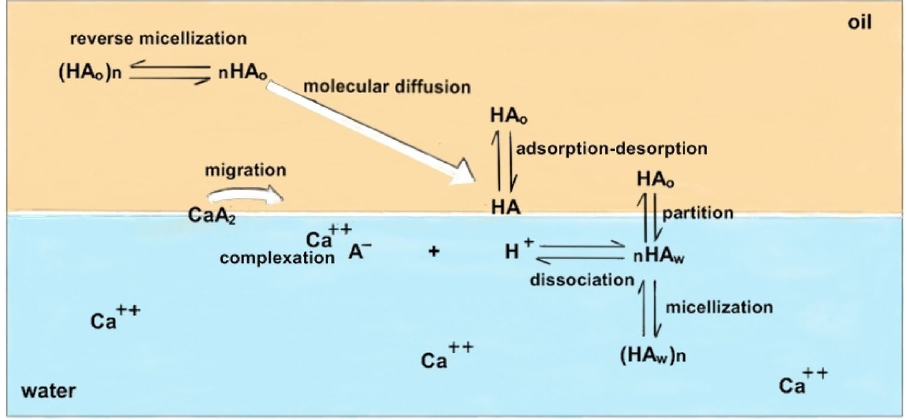
Fig. 2 Schematic of the process of metal naphthenate formation and associated acid equilibria at alkaline